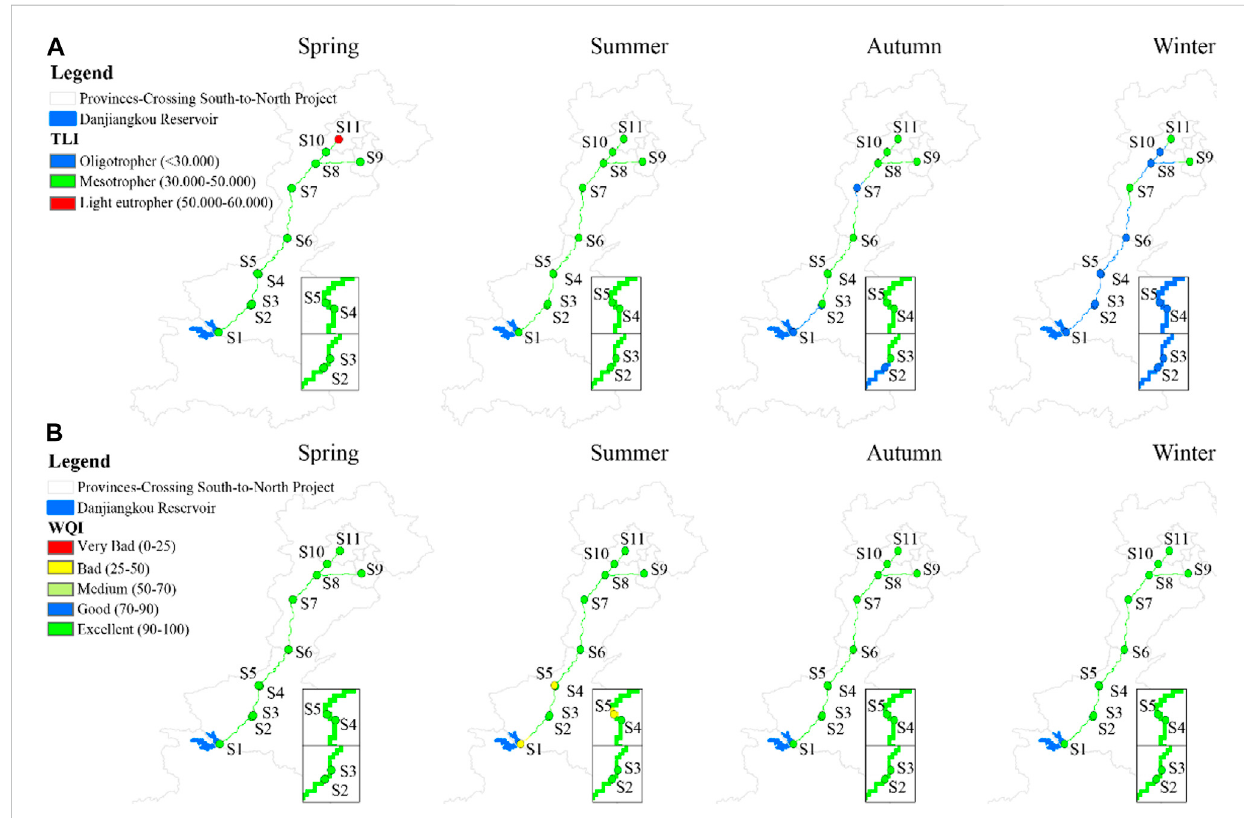
FIGURE 5 Spatio-temporal distribution of TLI and WQI in the middle route of South-to-North Water Diversion Project. (A) Spatio-temporal distribution of TLI; (B) spatio-temporal distribution of WQI.